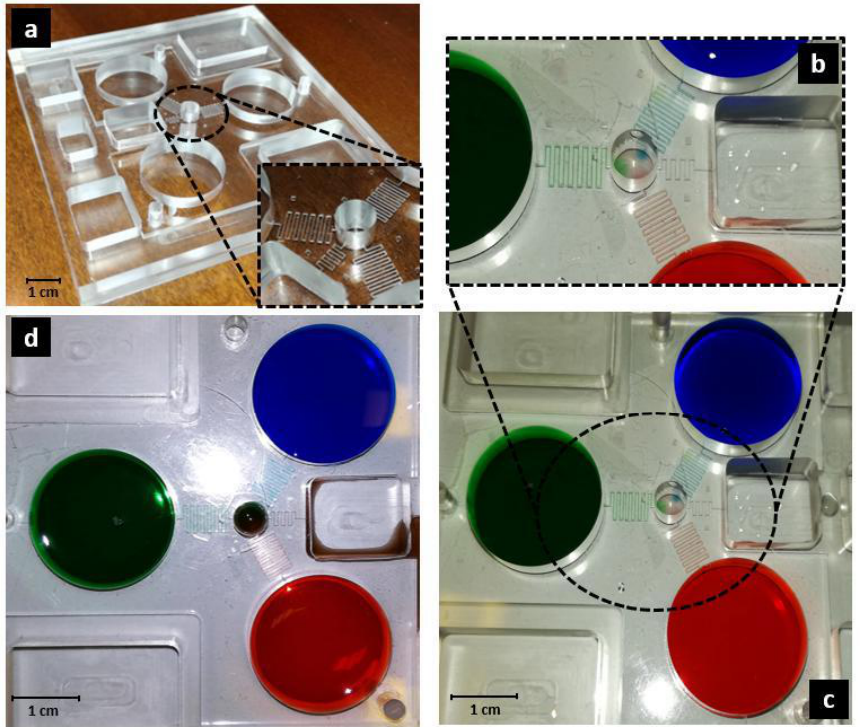
Figure 4. Isometric view of the fabricated microfluidic device. ( a ) A particular of the micro-channels is shown; ( b , c ) Diffusion after almost 600 s and ( d ) after 3 hours during the experiment with food dyes, according to the diffusion simulation shown in Figure 3.